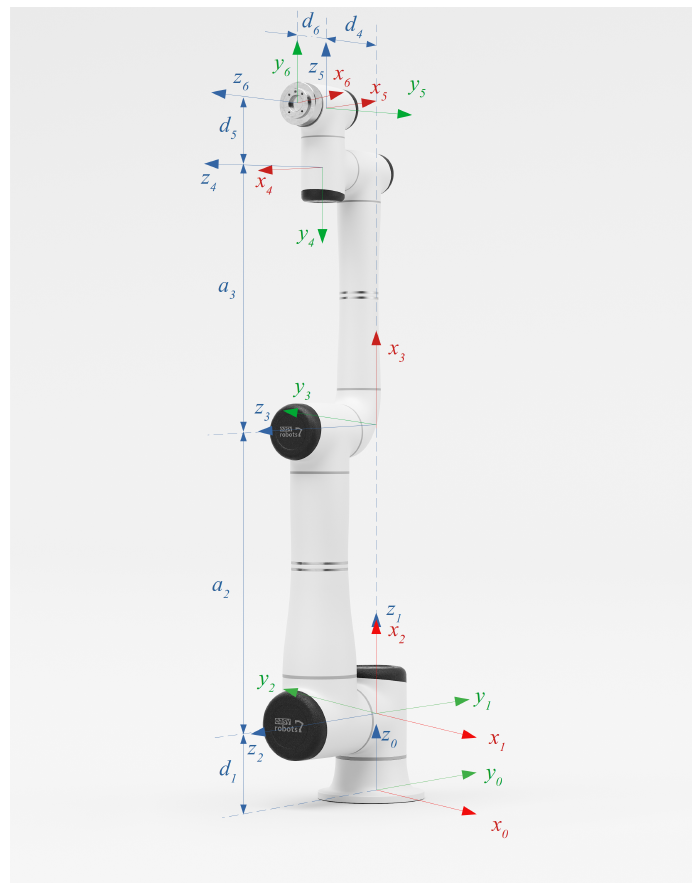
Figure 3. Three-dimensional drawing of the ES5 robot with assigned local coordinate systems according to the Denavit–Hartenberg